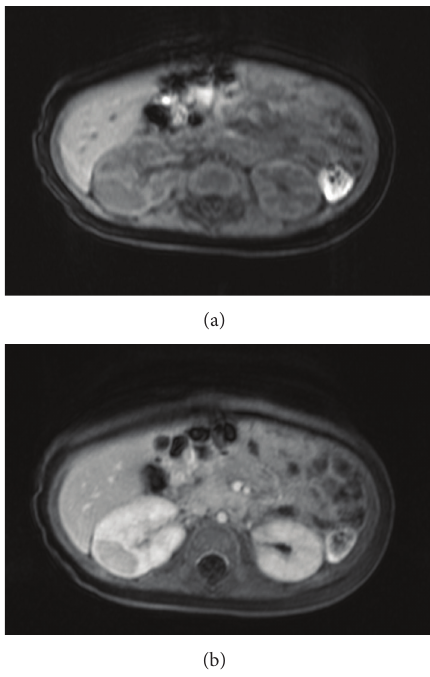
Figure 1: Noncontrast (a) and contrast enhanced (b) T1 weighted MR images show a large hypointense cortical mass at the right kidney and multiple smaller foci in both kidneys.